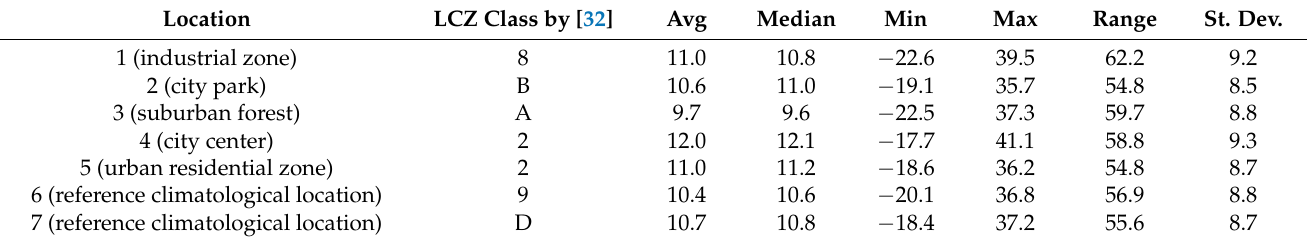
Table 5. Basic statistical analysis of the AT over the entire period (August 2011–October 2014). Adapted from [46]. Location LCZ Class by [32] Avg Median Min Max Range St.